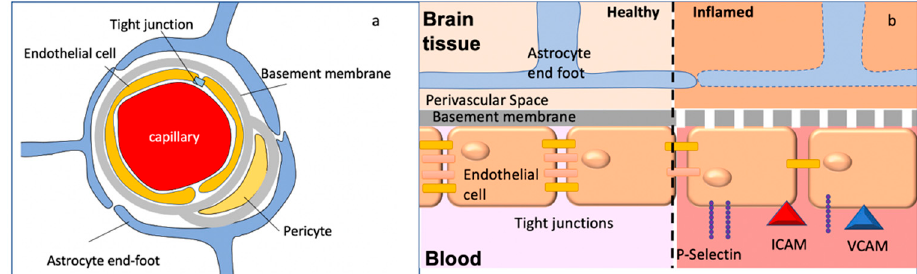
Figure 2. Blood–brain barrier. ( a ) Cellular components of the BBB. For details, see text. ( b ) Breakdown of BBB integrity. Inflammatory conditions induce the expression of P-selectin on the endothelial cells of the BBB, allowing PSGL-positive lymphocytes to tether. Tight junction proteins decrease in expression, and the basement membrane breaks down. Finally, the breakdown of the astrocyte end-feet allows access to the brain parenchyma.